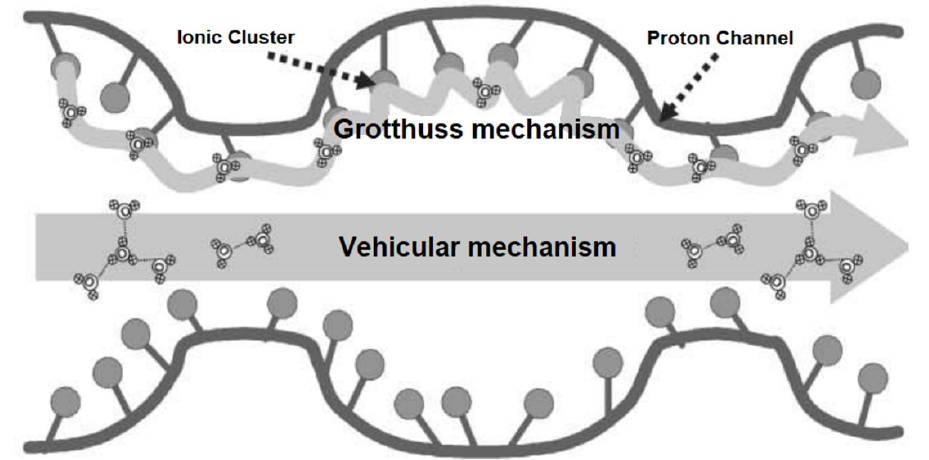
Figure 2. Schematic diagram of protons transport in PEM when DMFC is in operation. Reproduced from Ref. [47].